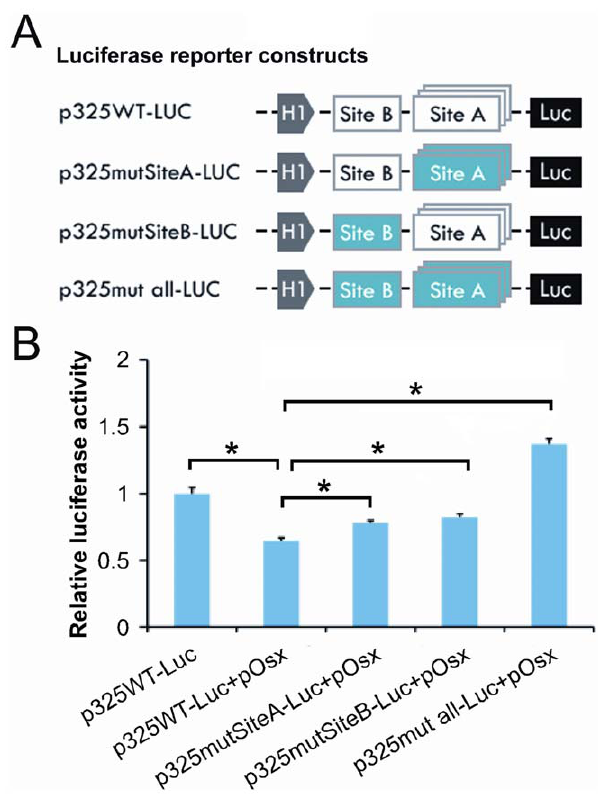
Figure 3. Both Site A and Site B are functional for Osterix- mediated NELL-1 promoter activity suppression. ( A ) Schematic of p325WT-Luc, p325mut all-Luc, p325mutSiteA, and p325mutSiteB constructs. Blue represents mutated Sp1 sites. ( B ) Graph depicting promoter activity on Saos-2 cells cotransfected with pOsx as well as p325WT-Luc or mutated NELL-1 promoter-luciferase constructs (p325mut all-Luc, p325mutSiteA-Luc, and p325mutSiteB-Luc, respec- tively). Data are reported as percent activity of control cells transfected with pCtr. (*p , 0.05)